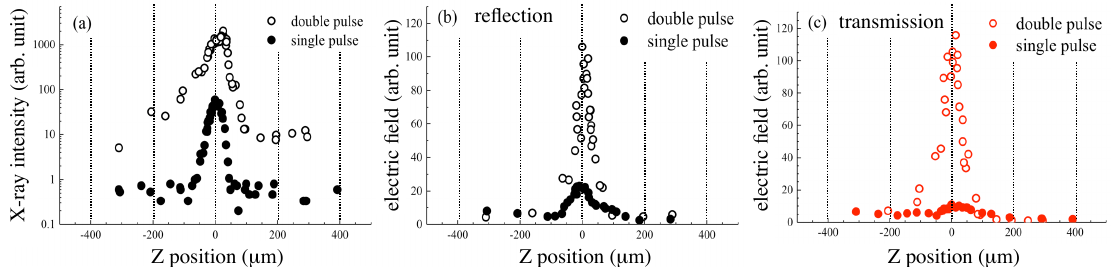
Figure 4. Z-position-dependent intensities of the X-ray in log-scale ( a ), the THz wave in the reflection ( b ) and the transmission ( c ) under the double-pulse excitation condition. Filled circles are under the single-pulse excitation condition, and open circles are under the double-pulse excitation condition, where the laser intensities for the main excitation pulse (horizontally-polarized, p-pol.) and the pre-pulse (vertically-polarized, s-pol., 4.6 ns in advance of the main pulse) were 0.4 mJ/pulse and 0.1 mJ/pulse,